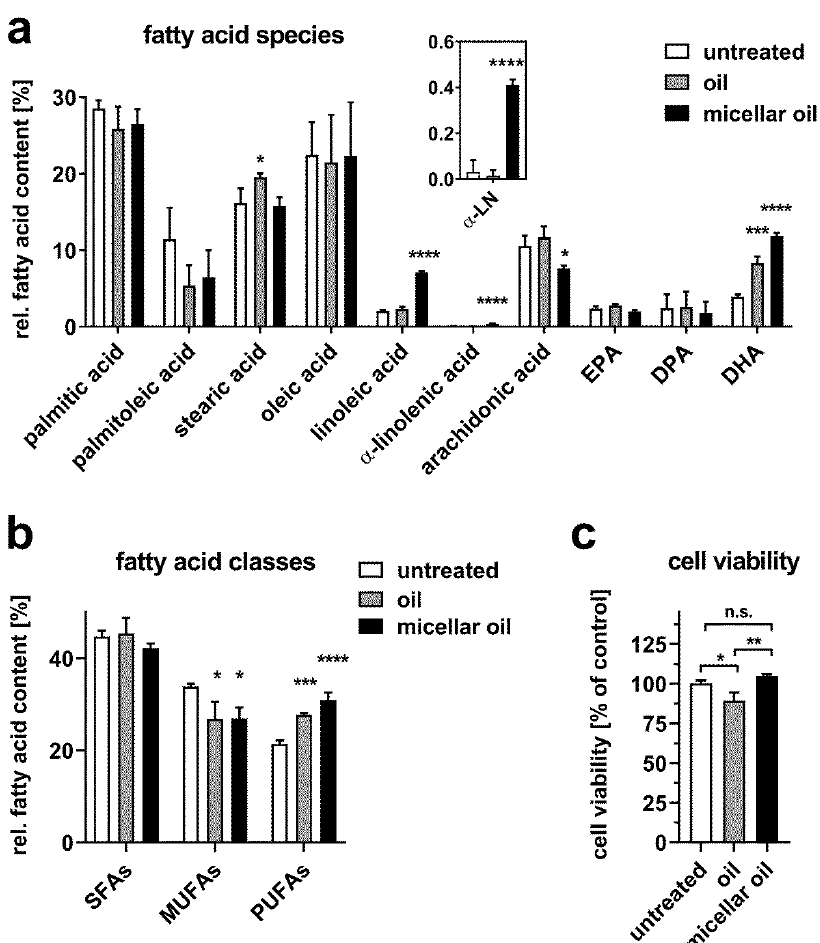
Figure 3. Uptake of fatty acids from algae oil into 3T3-L1 adipocytes. Cells were incubated with native or micellar oils at a final concentration of 0.5% for 6 h. Total fatty acid content was measured by GC-MS. Relative fatty acid composition ( a ) and distribution of fatty acid classes ( b ) are shown. The inset indicates an enlarged view on α -linolenic acid ( α -LN) levels. Cell viability was assessed after incubation with 0.5% oil or micellar oil for 24 h ( c ). Data are derived from three independent experiments. Bars represent mean ± SD. Asterisks indicate statistically significant di ff erences from untreated controls. **** p < 0.0001, *** p < 0.001, ** p < 0.01 and * p <